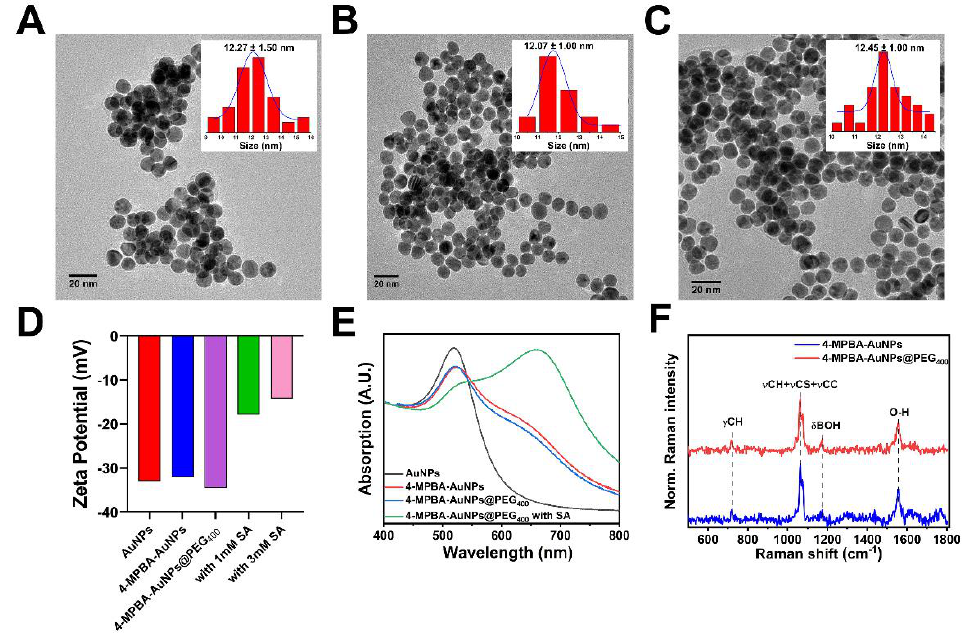
Figure 2. The representative TEM images of the ( A ) 4-MPBA-AuNPs, ( B ) 4-MPBA-AuNPs@PEG 400 , and ( C ) 4-MPBA-AuNPs@PEG 400 with SA. ( D ) The zeta potential of AuNPs, 4-MPBA-AuNPs, 4-